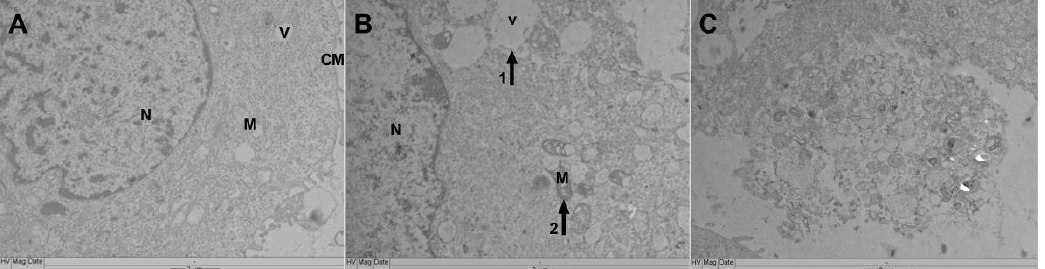
Figure 9. Morphological changes of SCC-25 cells assessed by transmission electron microscopy, after 24 h of treatment. ( A ) SSC-25 without treatment (control); ( B ) SCC-25 treated with 500 µg/mL of VALE-loaded-hydrogel (arrow 1: cytoplasmatic vacuole; arrow 2: mitochondria damage); ( C ) SCC-25 treated with 500 µg/mL of VALE-loaded-hydrogel: intensive cell lysis. M: Mitochondria; V: vacuole; CM: cytoplasmatic membrane; N: nucleus. Scale bars: 2 µm.